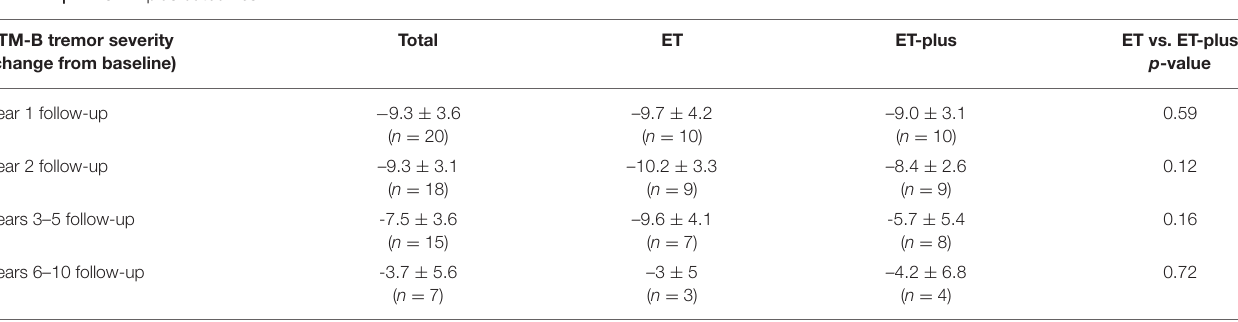
TABLE 2 | ET vs. ET-plus